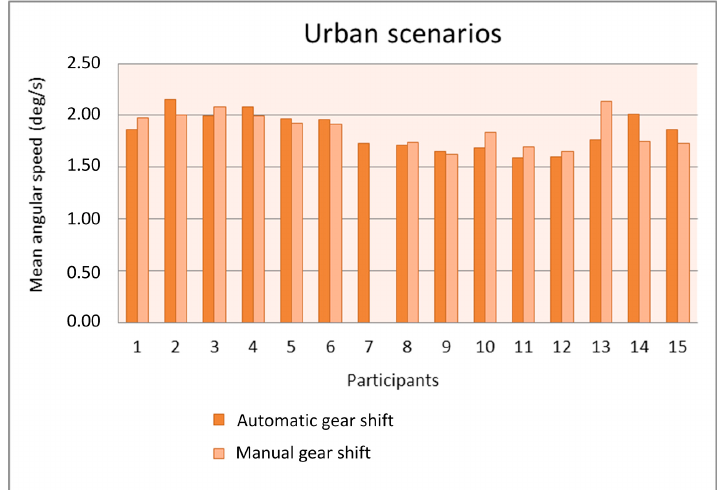
Figure 12. Mean angular speed as a function of the gear shift type in the urban scenarios.